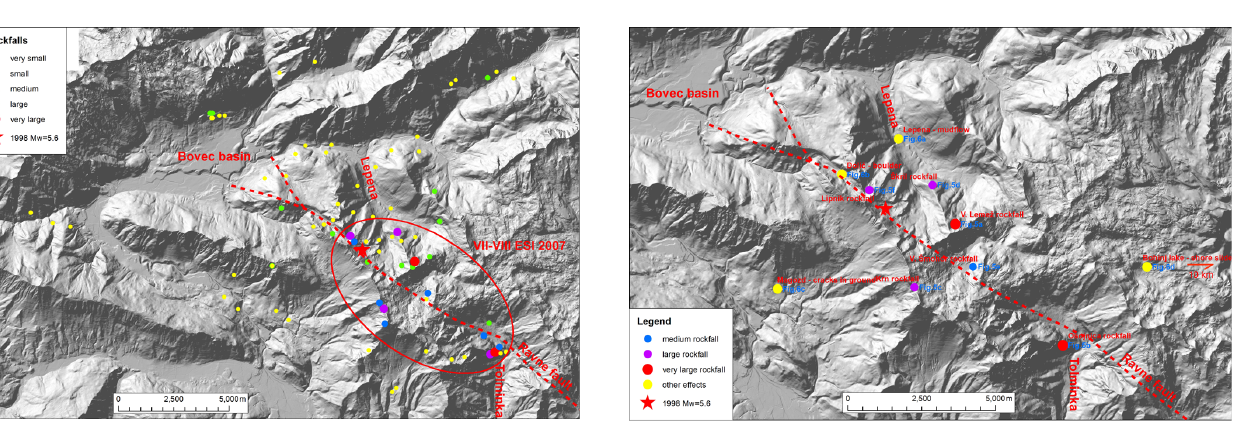
Fig. 4. Location map of rockfalls and other environmental effects shown in Figs. 5 and